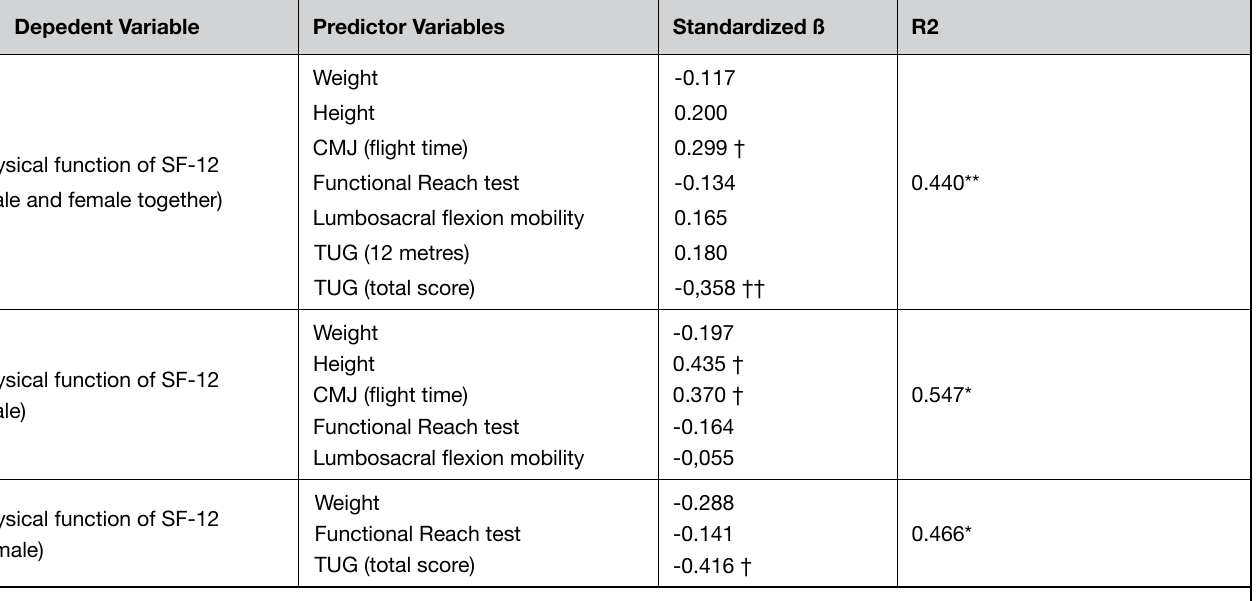
Table 3: Multiple regression